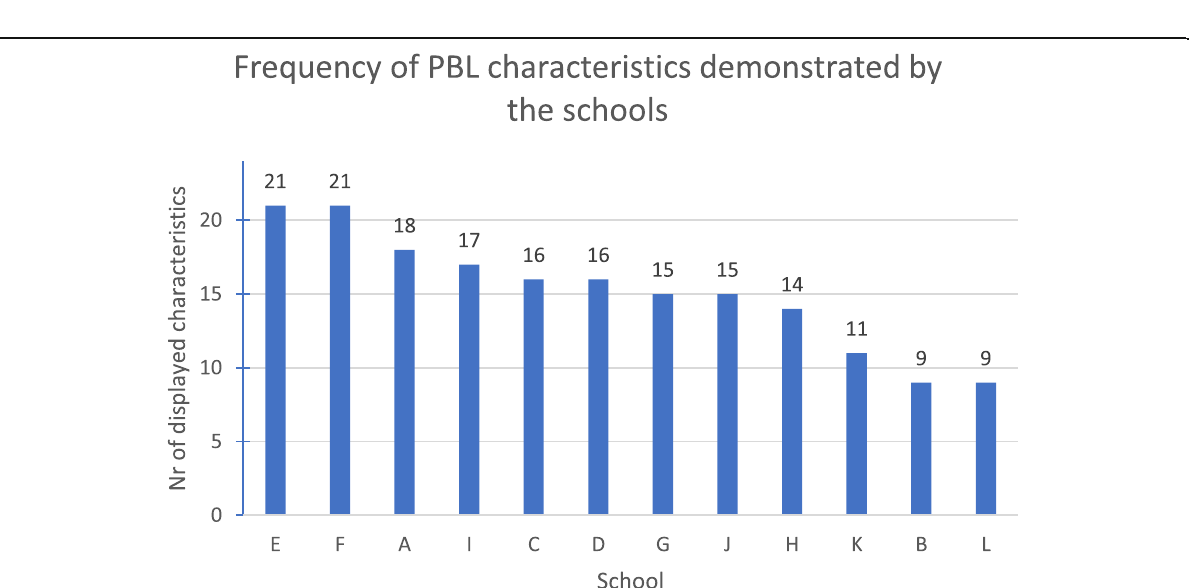
Fig. 1 Frequency of the PBL characteristics demonstrated by the schools A-L ( n = 12, see Tables 4 and